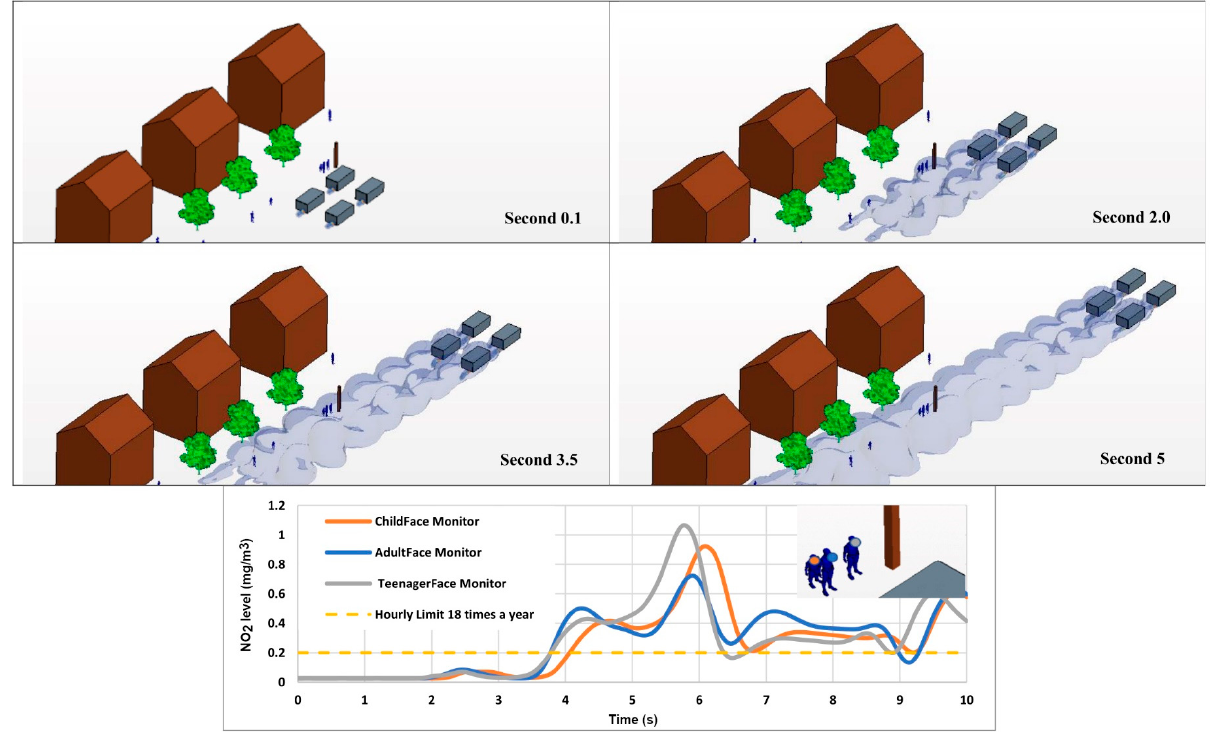
Figure 3. NO 2 levels for the pedestrians standing by the traffic light.